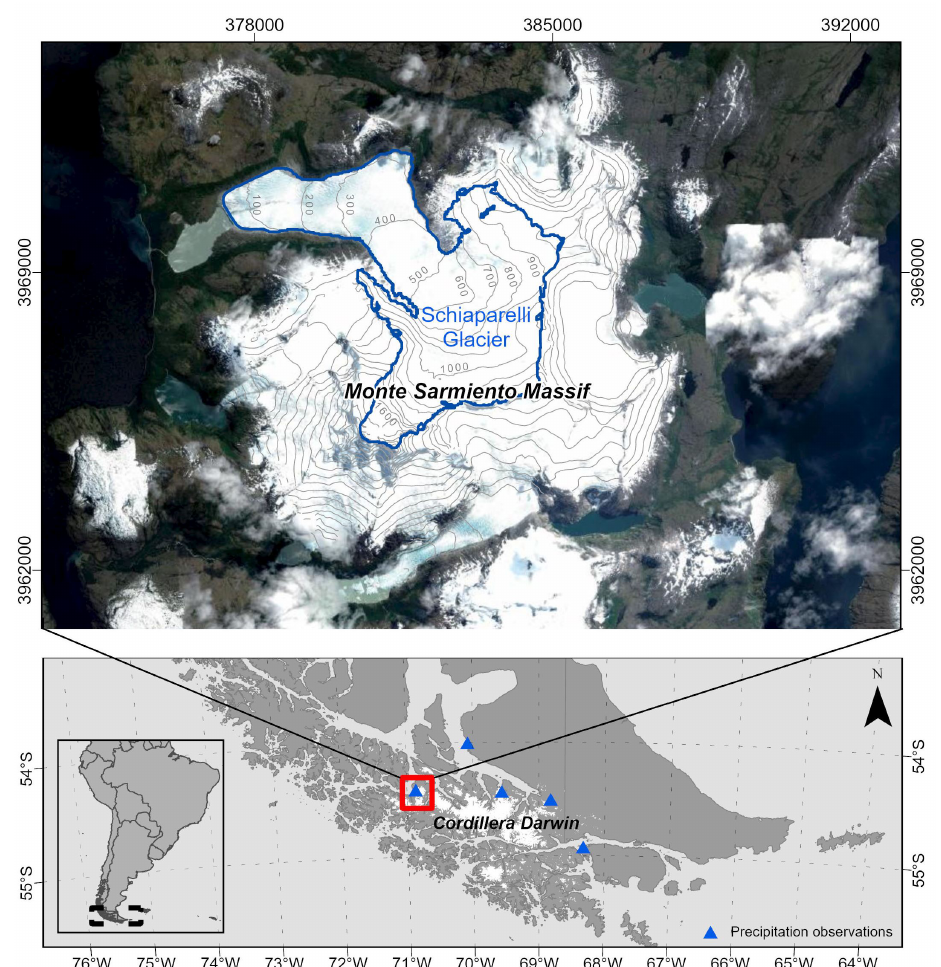
Figure 1. Location of the Monte Sarmiento Massif and location of the weather stations used in this study; glacier outlines are visualized for 2016 based on the glacier inventory by [2]. Sources of the satellite imagery: ESRI, Digital Globe, GeoEye, Earthstar Geographics, CNES/Airbus DS, USDA, USGS, AeroGRID, IGN, and the GIS User Community. Elevation contour lines of 100m are illustrated. The coordinates are in UTM zone 19S in